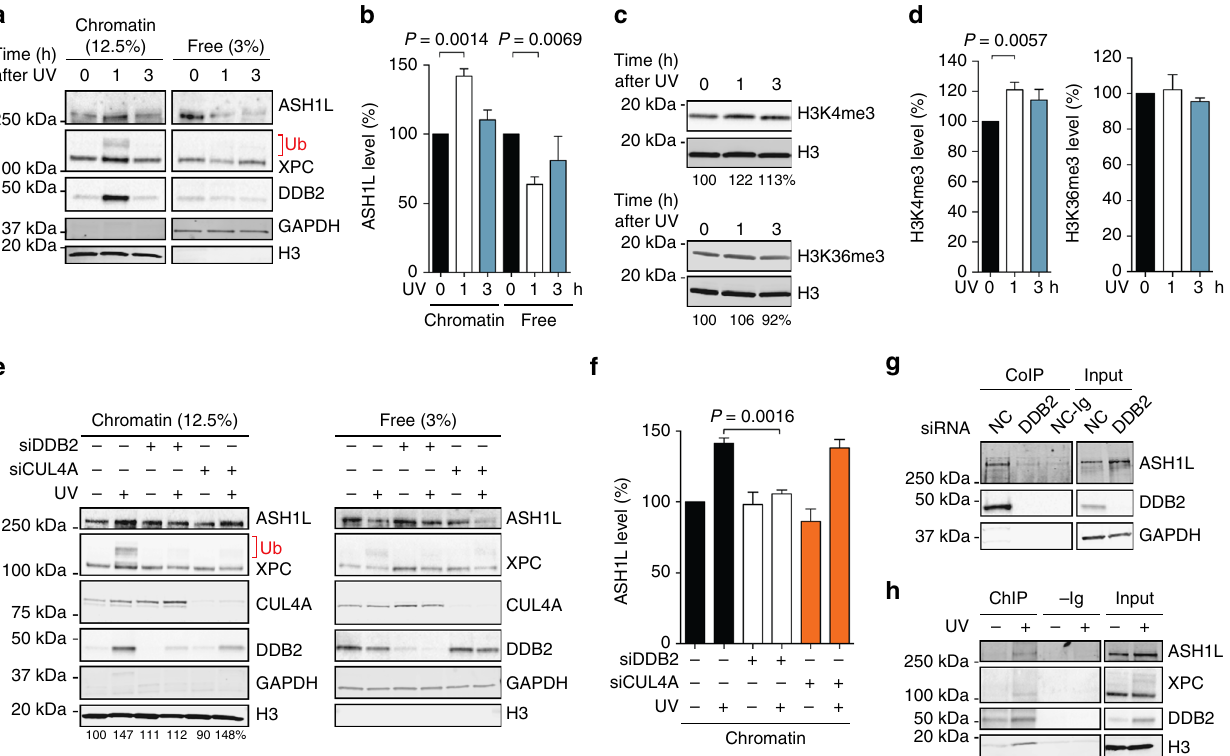
Fig. 1 DDB2-dependent recruitment of ASH1L to chromatin. a Recruitment of DDB2, XPC and ASH1L to chromatin detected by immunoblotting. The chromatin of HeLa cells exposed to UV-C (10 J m – 2 ) was analyzed, at different times, by salt extraction to release free proteins, followed by MNase solubilization. GAPDH and H3 were loading controls for free proteins and solubilized chromatin, respectively. Ub, ubiquitinated XPC protein. b Quanti fi cation of ASH1L recruitment to chromatin normalized to H3 ( n = 4 independent experiments). ASH1L levels in unirradiated chromatin are set to 100%; error bars show s.e.m. and signi fi cance was calculated using the one-sample t-test. c Increased H3K4me3 levels following UV radiation (10 J m – 2 ). Whole cell lysates were probed with antibodies against the indicated forms of H3. Numbers at the bottom of each blot indicate the quantity of methylated H3 normalized to total H3 and relative to unirradiated controls. d Quanti fi cation of H3K4me3 and H3K36me3 normalized to total H3 ( n = 6 independent experiments, one-sample t-test), values in unirradiated controls are set to 100%. e DDB2-dependent recruitment of ASH1L to chromatin. HeLa cells were siRNA-transfected as indicated 48 h before UV radiation (10 J m – 2 ). After a 1-h recovery, cells were analyzed by salt extraction, chromatin solubilization and immunoblotting. NC, non-coding. Numbers at the bottom of the blot indicate ASH1L protein levels normalized to H3 and relative to the unirradiated control. f Quanti fi cation of ASH1L recruitment to chromatin, relative to free ASH1L, normalized to H3 and GAPDH ( n = 4 independent experiments, one-sample t-test). g Co-immunoprecipitation (Co-IP) of ASH1L with DDB2. HeLa cells were siRNA-transfected 48 h before collection of 0.3-M NaCl extracts. These extracts were immunoprecipitated with anti-DDB2 antibodies and analyzed by immunoblotting; – Ig, immunoglobulins omitted (the DDB2- pro fi cient extract was subjected to the same Co-IP procedure except that anti-DDB2 antibodies were left out). h Chromatin immunoprecipitation (ChIP) using antibodies against DDB2 demonstrating that DDB2 and ASH1L interact in the chromatin of UV-irradiated (10 J m – 2 ) HeLa cells; – Ig, immunoglobulins omitted (samples were subjected to the same ChIP procedure except that anti-DDB2 antibodies were left